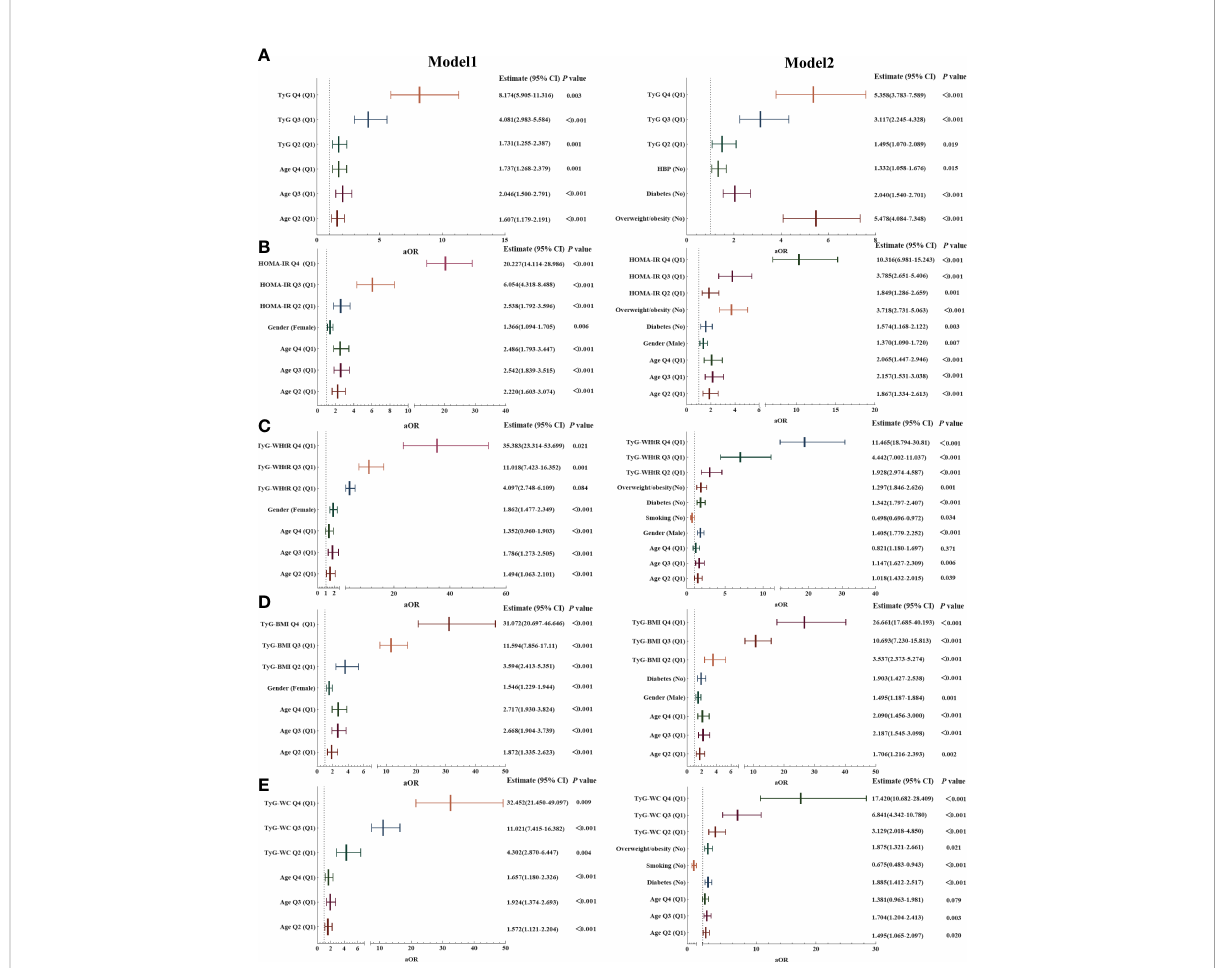
FIGURE 2 Association of the fi ve parameters with non-alcoholic fatty liver disease (NAFLD). (A) Association of TyG index with NAFLD. (B) Association of HOMA-IR score with NAFLD. (C) Association of TyG-WHtR with NAFLD. (D) Association of TyG-BMI with NAFLD. (E) Association of TyG-WC with NAFLD.Model 1: Adjusted for age and gender.Model 2: Adjusted for age, gender, PIR, education level, smoking status, diabetes, hypertension, and obesity or overweight.Note: Q1 – 4 = quartiles 1 – 4; speci fi c values are as follows:Age Q1 < 36 years, 36 ≥ Age Q2 ≤ 53 years, 53 > Age Q3 ≤ 65 years, Age Q4 > 65 years;TYG Q1 < 8.02, 8.02 ≥ TYG Q2 < 8.50, 8.5 ≥ TYG Q2 < 8.96, TYG Q4 ≥ 8.96;HOMA-IR Q1 < 1.38, 1.38 ≥ HOMA-IR Q2 < 2.24, 2.24 ≥ HOMA-IR Q2 < 3.84, HOMA-IR Q4 ≥ 3.84;TyG-WHtR Q1 < 4.34, 4.34 ≥ TyG-WHtR Q2 < 5.05, 5.05 ≥ TyG- WHtR Q2 < 5.81, TyG-WHtR Q4 ≥ 5.81;TyG-BMI Q1 < 203.68, 203.68 ≥ TyG-BMI Q2 < 240.41, 240.41 ≥ TyG-BMI Q2 < 287.39, TyG-BMI Q4 ≥ 287.39.TyG-WC Q1 < 720.71, 720.71 ≥ TyG-WC Q2 < 838.50, 838.50 ≥ TyG-WC Q2 < 959.81, TyG-WC Q4 ≥